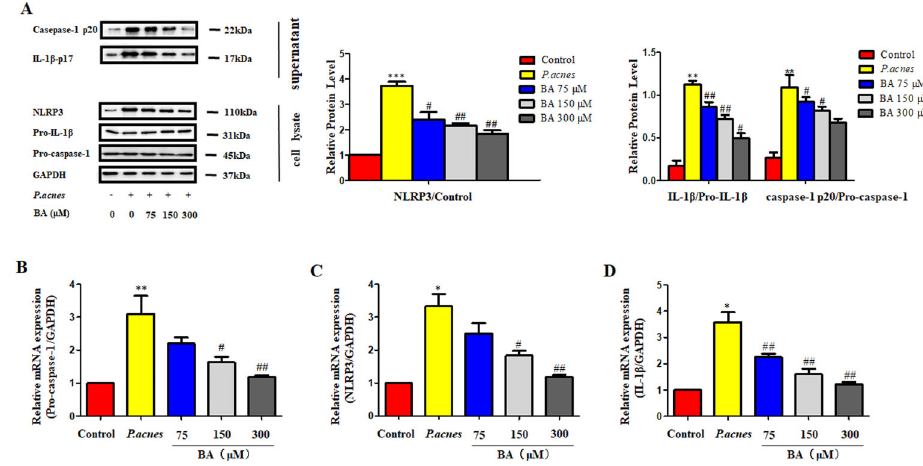
Figure 3. Effect of baicalin (BA) on the expression of interleukin (IL)-1 b and the NLRP3 in fl ammasome in P. acnes- induced THP-1 cells. The THP-1 cells were pre-treated with BA at concentrations of 75, 150, and 300 m M for 24 h, and subsequently stimulated with heat- killed P. acnes for 12 h in 6-well plates. A , The cell supernatants were harvested for the detection of IL-1 b and caspase-1 p20. Western blotting was performed for assessing the expression of NLRP3 and pro-caspase-1. B - D , qRT-PCR for quantifying the mRNA levels of pro-caspase-1, NLRP3, and IL-1 b . The data are reported as means ± SE from at least three independent experiments. *P o 0.05, **P o 0.01, ***P o 0.001 vs control; # P o 0.05, ## P o 0.01 vs P. acnes alone